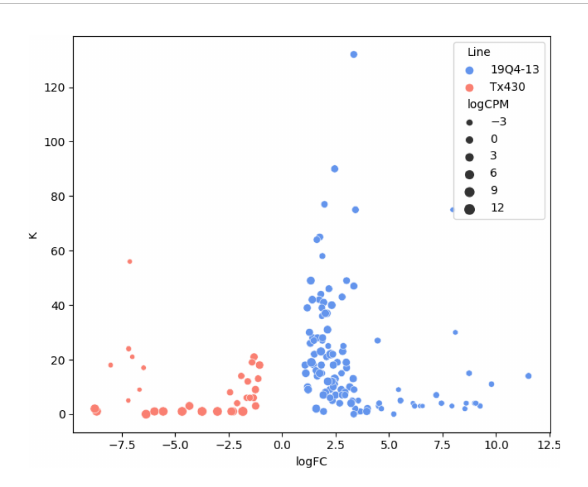
FIGURE 5 Relationship between log10 fold change and predicted lysine residues among DEGs. Genes upregulated in 19Q4-13 appear to have a higher number of predicted lysine residues than Tx430. Among DEGs, the mean number of lysine residues was 15.03 in 19Q4-13 up regulated genes versus 7.94 in genes upregulated in wild type (p=0.003). Blue indicates DEGs upregulated in 19Q4-13, while pink indicates DEGs upregulated in Tx430.